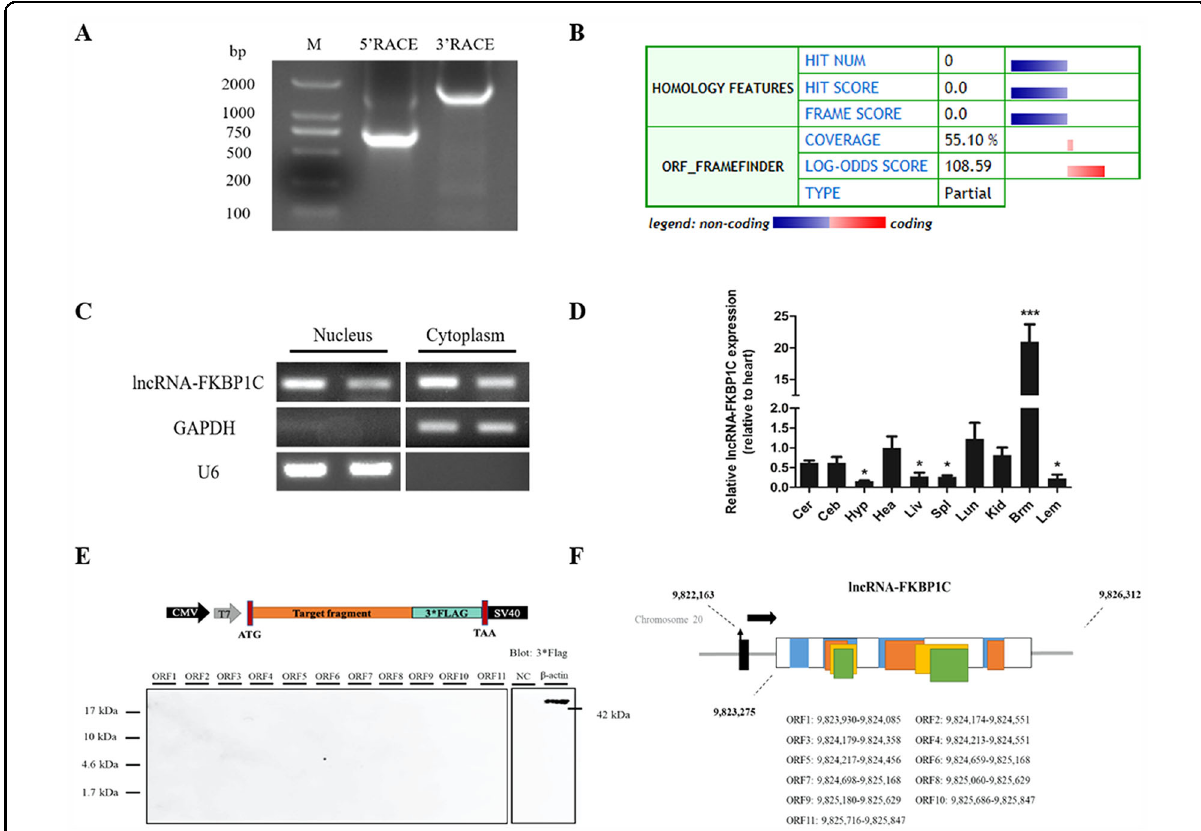
Fig. 1 Identi fi cation of lncRNA-FKBP1C. A Results of 5 ′ RACE and 3 ′ RACE. M, DL2000 Marker; 5 ′ RACE product, 690 bp; 3 ′ RACE product, 1465 bp. B Analysis obtained from the Coding Potential Calculator (http://cpc.cbi.pku.edu.cn/) based on evolutionary conservation and ORF attributes. C LncRNA-FKBP1C is localized in the cytoplasm and nucleus of chicken primary myoblasts. GAPDH and U6 serve as cytoplasmic and nuclear localization controls, respectively. D XH chicken tissue expression pro fi les of lncRNA-FKBP1C. Cer, cerebrum; Ceb, cerebellum; Hyp, hypothalamus; Pit, pituitary; Hea, heart; Liv, liver; Spl, spleen; Lun, lung; Kid, kidney; Brm, breast muscle; Lem, leg muscle. E Western blot analysis of the coding ability of lncRNA-FKBP1C. The possible ORF of lncRNA-FKBP1C was cloned into the eukaryotic expression vector pcDNA3.1-3xFlag. Untransfected DF-1 cells were used as a negative control (NC) and DF-1 cells transfected with pcDNA3.1-3xFlag- β -actin were used as a positive control. The upper panel shows the model target fragment in the pcDNA3.1-3xFlag vector. The lower left panel is the blot of ORFs 1 – 11, and the lower right panel is the blot of the NC and β -actin. F The location of 11 potential ORFs in lncRNA-FKBP1C. 11 potential ORFs are arranged in order according to their positions. Results are shown as mean ± S.E.M. and the data are representative of at least three independent assays. Independent sample t-test was used to analyze the statistical differences between groups (* P < 0.05, *** P <